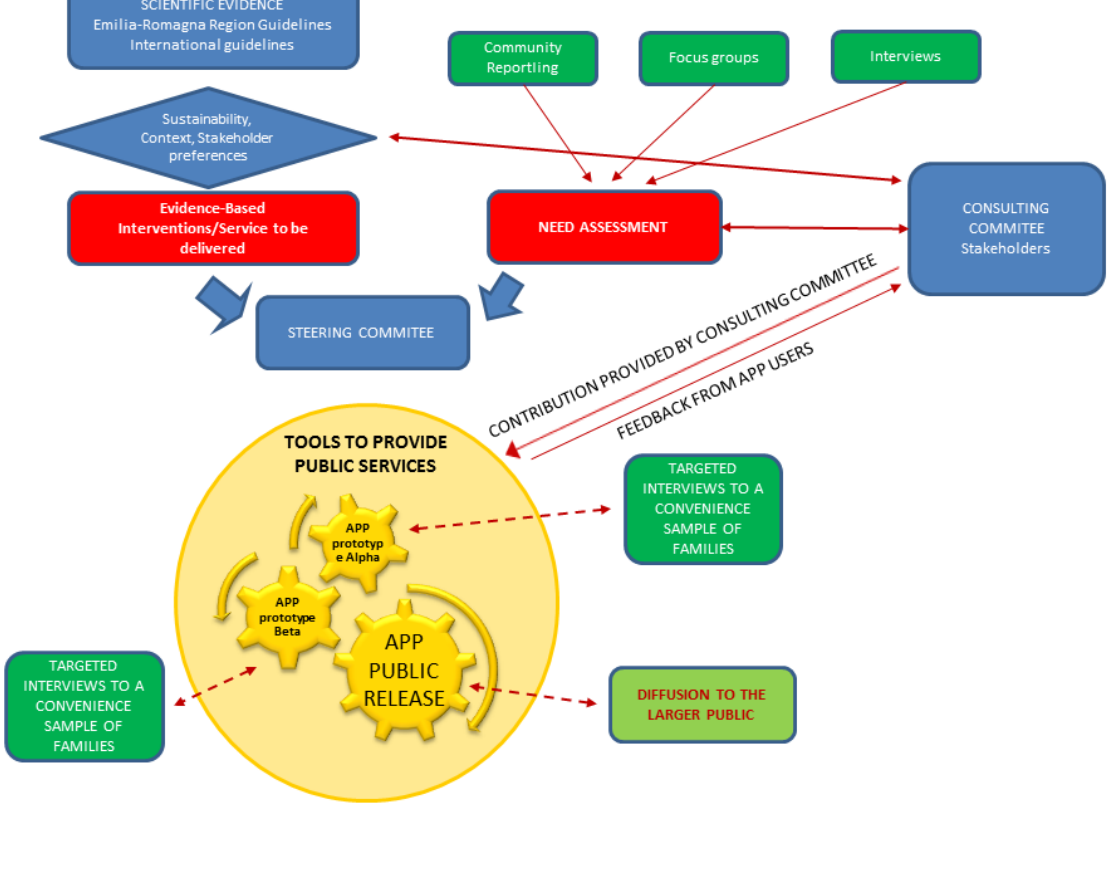
Figure 3. Cocreation strategies for the design, production, and governance of the app in the Reggio Emilia pilot project on childhood obesity